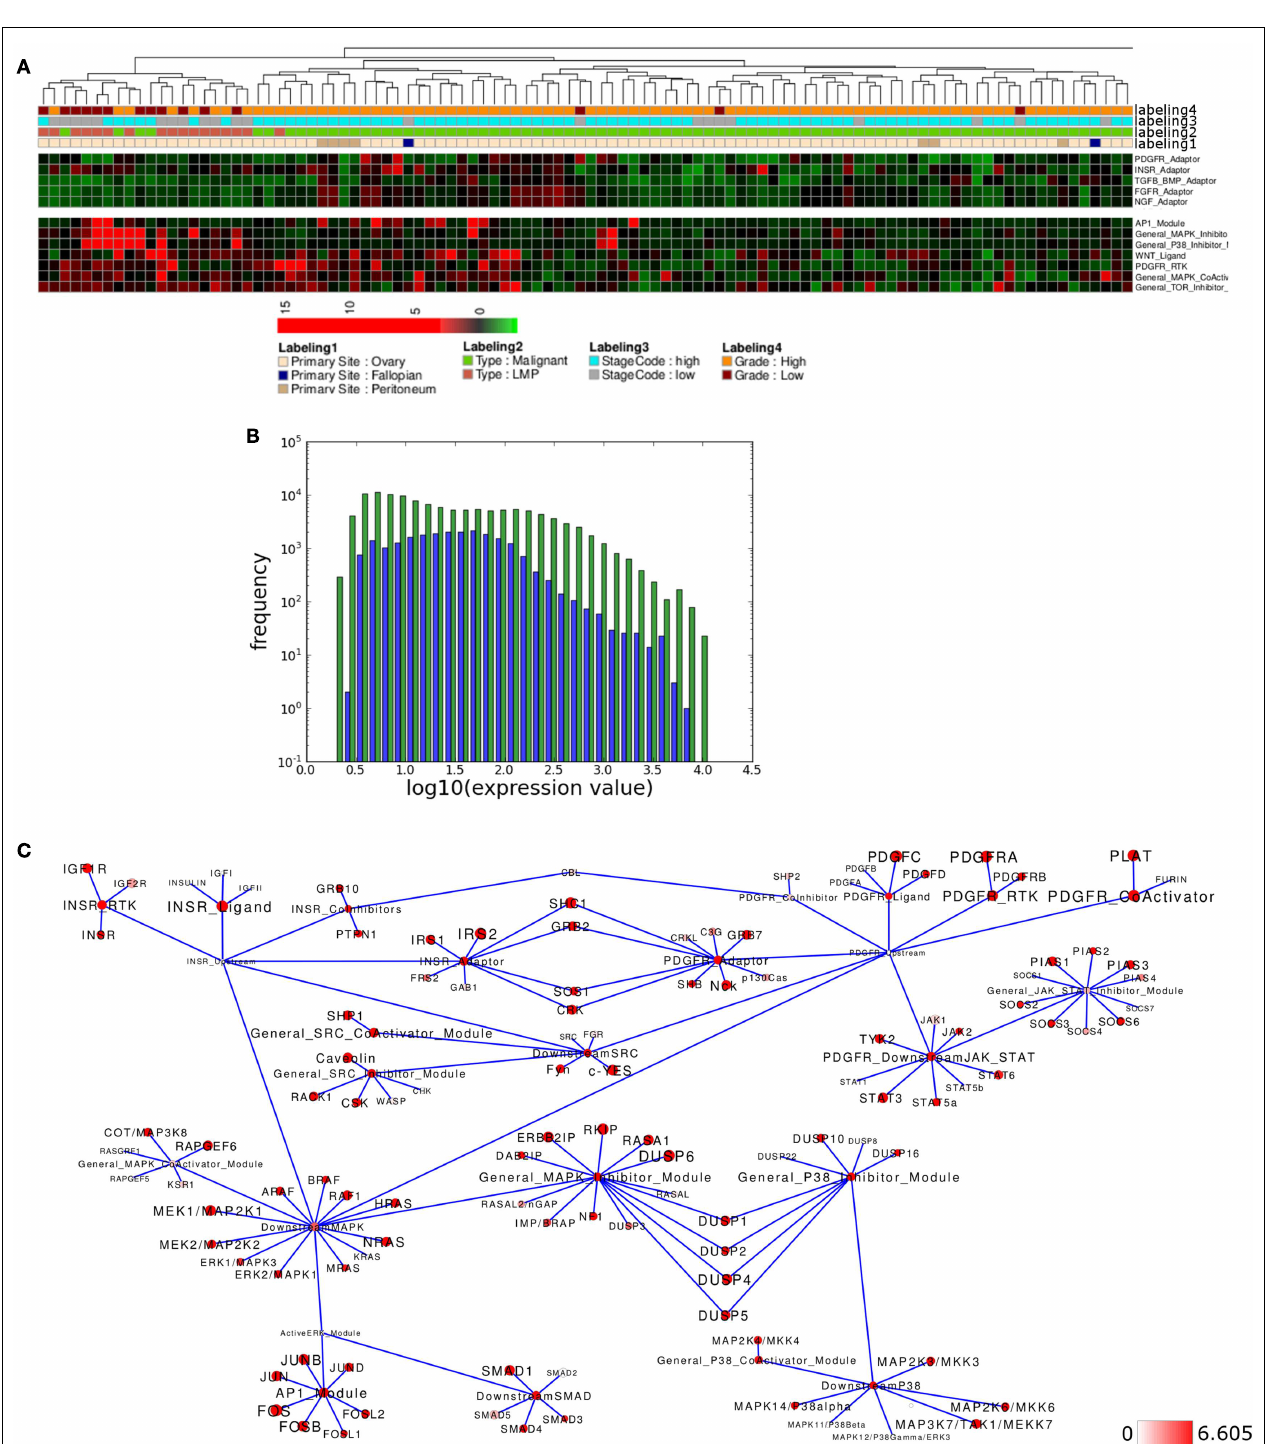
associated with the network. (C) Network diagram of the top 15% differential expressed modules and genes comparing the difference between average network module activity in LMP versus all other samples; node color and node label size are initialized with log2 difference of the average gene-expression values of LMP versus all other samples; red color indicates expression above a log2 difference ≥ 6.605 (max.